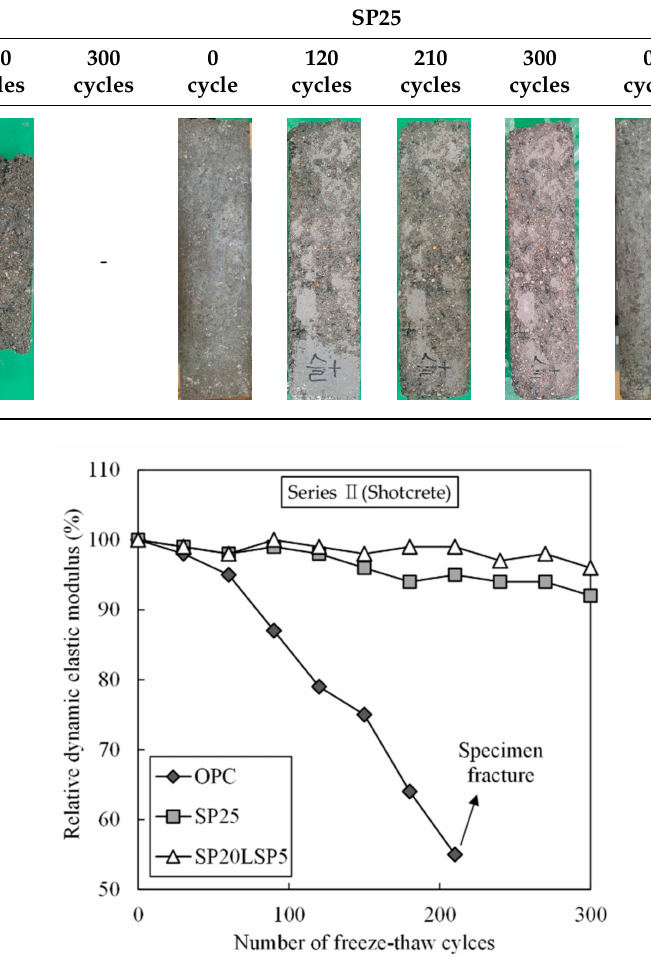
Figure 9. Freeze–thaw resistance performance of